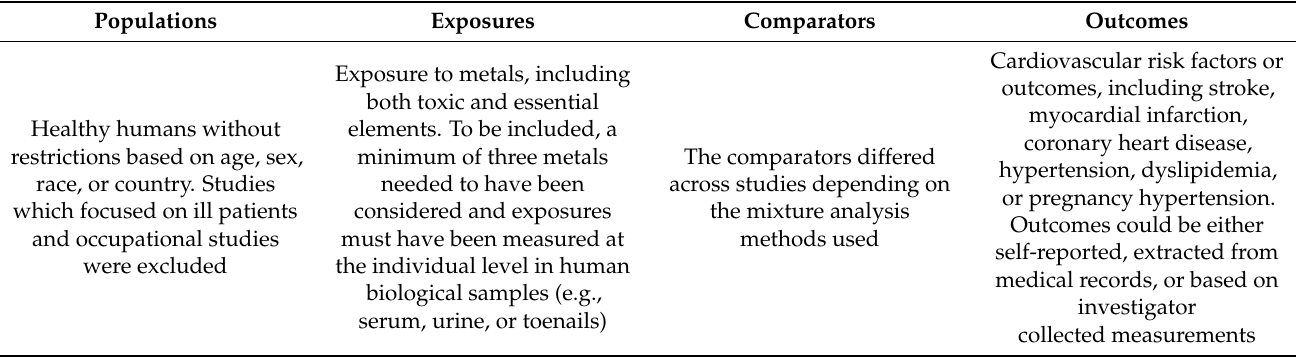
Table 1. Populations, Exposures, Comparators, and Outcomes (PECO)